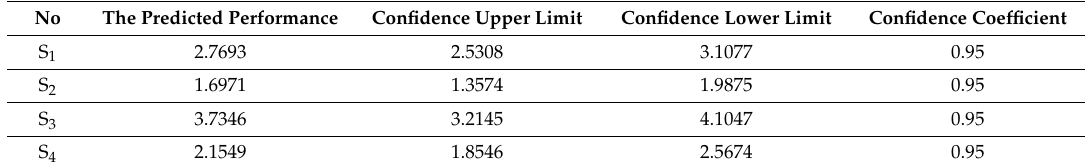
Table 3. The confidence interval estimation.